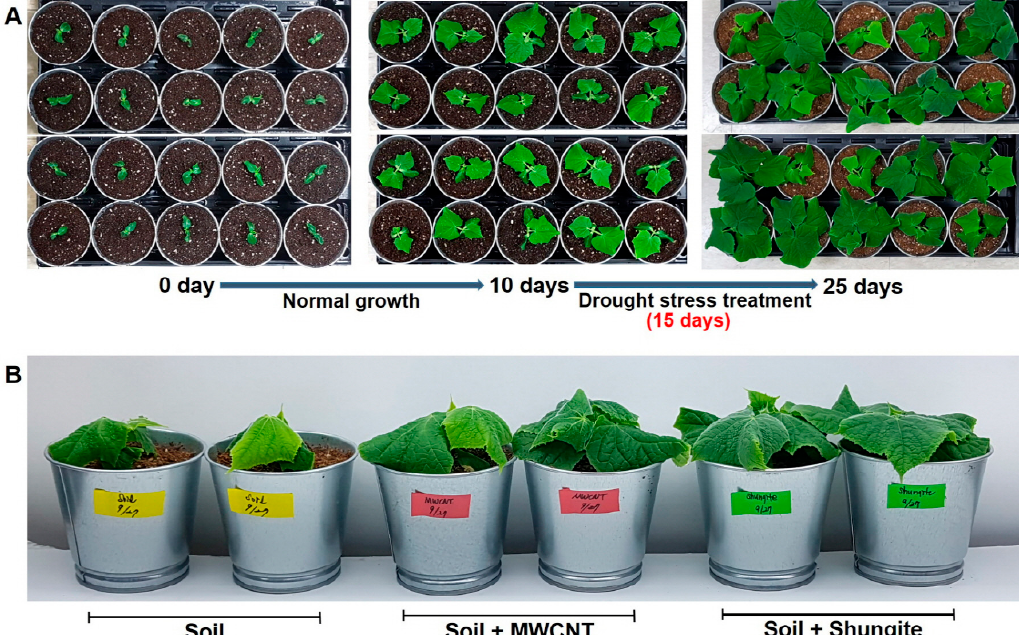
Figure 1. Improving wilt symptoms in leaves through the addition of MWCNT and shungite, under drought conditions. ( A ) Overview of the experimental design. ( B ) Plant status at the time of sampling. Ten-day-old cucumber (“Eun-sung”) plants were moved to drought conditions. Plants were grown for 15 days under drought conditions. MWCNT: multiwalled carbon